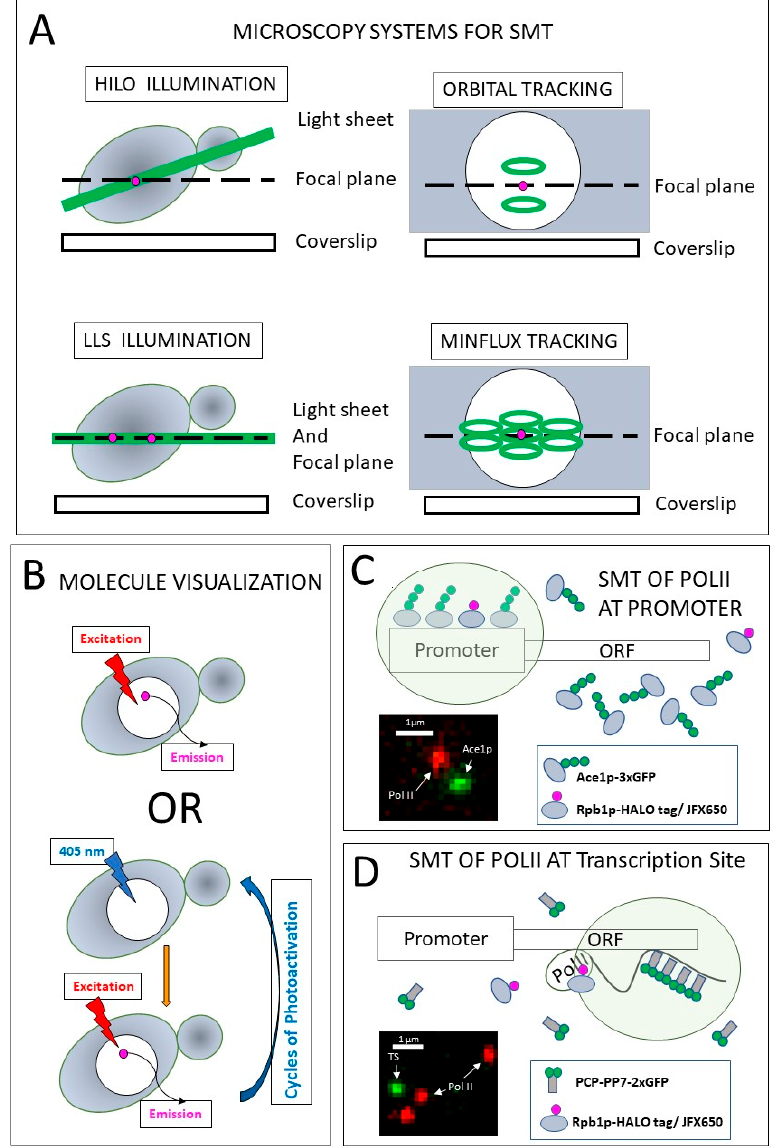
Figure 2. Imaging fluorescent molecules. ( A ) Schematics of microscopy systems for SMT. HILO and LLS illumination increase SNR. Orbital tracking follows molecules in 3D with two-color imaging; MINFLUX increases spatiotemporal resolution and allows 2D and 3D imaging in a single-color channel. ( B ) Schematics of molecule visualization ensure that few molecules at a time are detected. Top: In a sparsely labeled nucleus, single molecules may be excited directly. Bottom: In a nucleus densely labeled with photoactivatable fluorophores, a fraction of the molecules is activated by the appropriate laser line and then excited for fluorescence; after photobleaching of activated particles, the cycle may be repeated. ( C ) Schematics of tracking of RNA Pol II at specific promoter. Insert: frame of the movie, RPO21 -HaloTag/JFX 650 (red) and Ace1p-3xGFP bound to promoter of CUP1 (green). ( D ) Schematics of tracking of RNA Pol II at specific TS. Insert: frame of the movie, RPO21 - HaloTag/JFX 650 (red) and PCP-PP7-GFP bound to stem-loops of the nascent mRNA of the single-copy reporter inserted into CUP1 locus